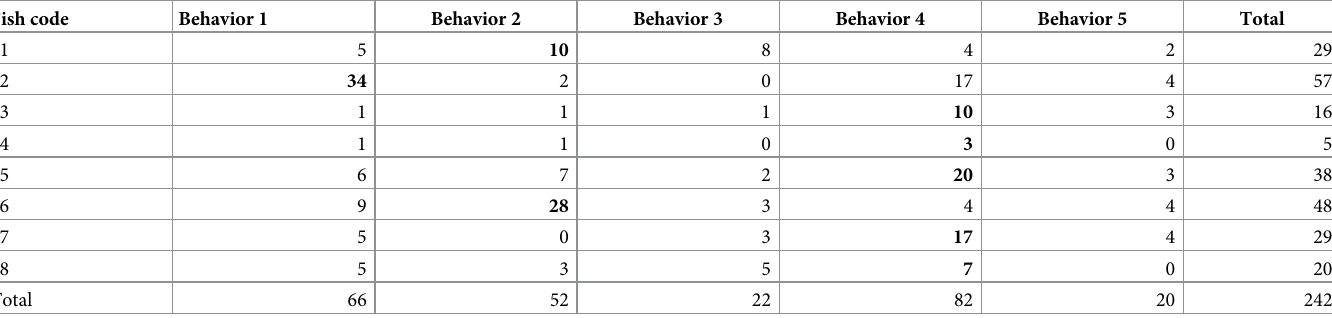
Table 2. Total occurrence of contingency testing behaviors shown by 8 fish during 20-minute observation/day in the first 7 days after mirror